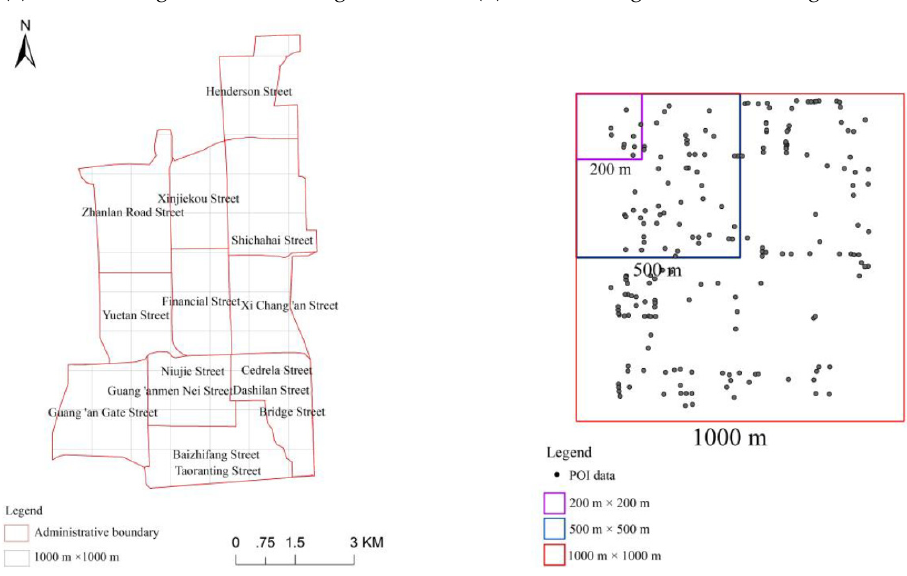
Figure 7. Division of the Xicheng District into grids with dimensions of 200 × 200 m, 500 × 500 m, and 1000 × 1000 m.